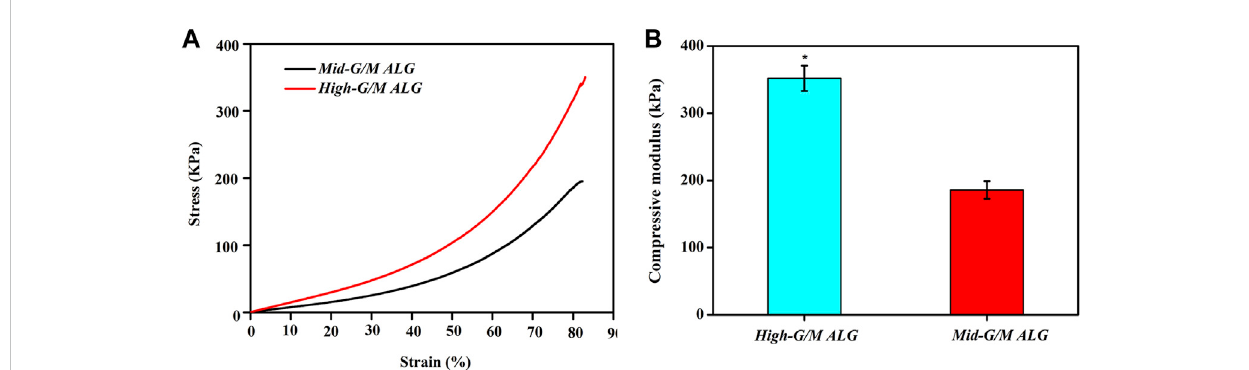
FIGURE 7 Compressivestress-straincurves (A) andcompressivemodulus (B) ofALG/COLhydrogels.Thecompressivemodulusiscalculatedfromtheslopeof the initial linear portion of the stress-strain curve. Results are expressed as mean ± standard deviation (SD). (* p < 0.05 indicates a signi fi cant difference between the two groups).